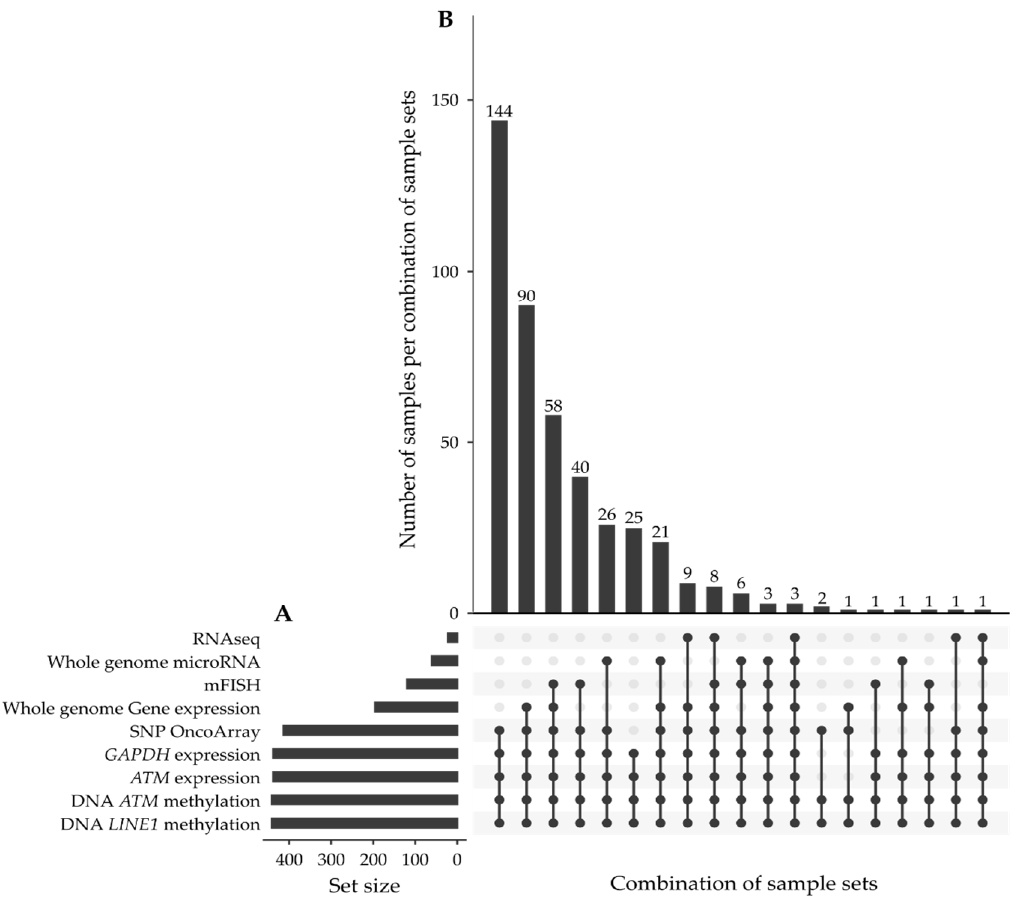
Figure 8. Present experimental data and their relationship on the individual level visualized in an UpSet Plot. ( A ) The graph represents the total number of individuals for which OMIC and functional data are available. ( B ) Number of individuals for which overlapping data are available for the various biological levels and combinations.